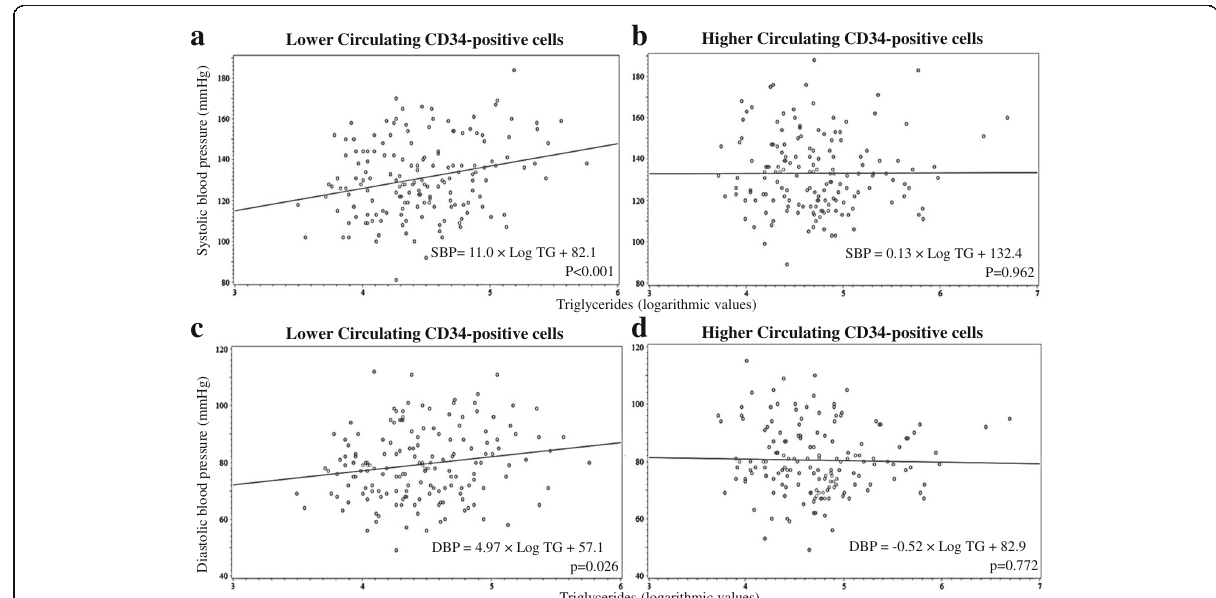
Fig. 1 Scatter plot of blood pressure (systolic and diastolic) and